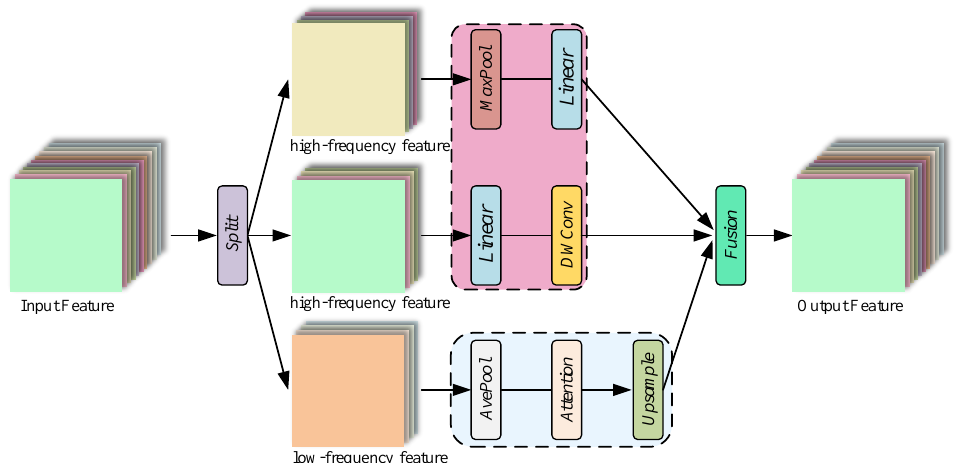
Figure 2. Structure diagram of the Inception token mixer in Inception